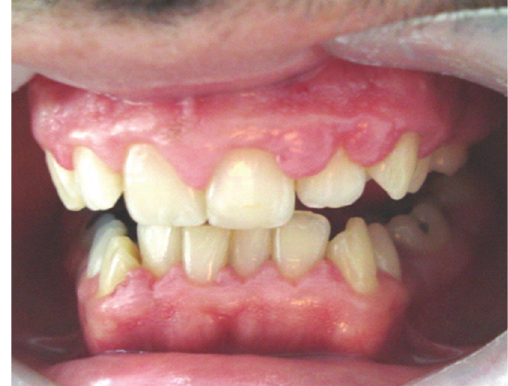
Figure 1: Gingival enlargement can be seen covering part of the coronal portion along with the absence of plaque or calculus (25-year-old male heart transplant patient who had cyclosporin treatment only).